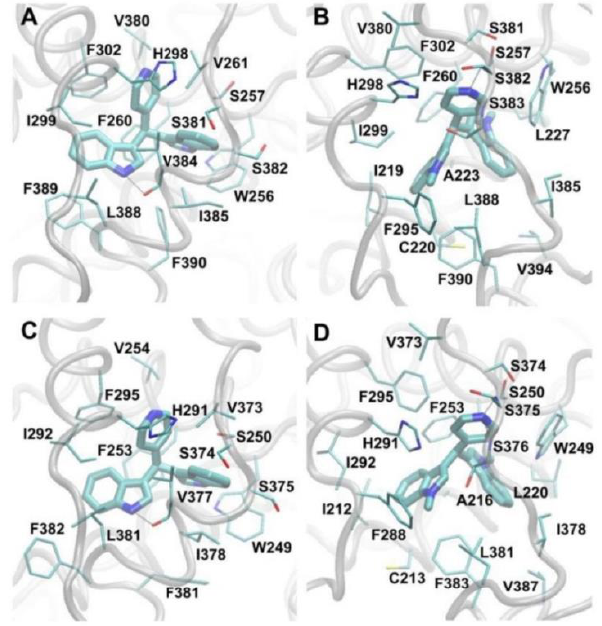
Figure 9. Molecular graphic images of ( A , C ) C-DIM-Pyr4 and ( B , D ) C-1,1-CH3-DIM-Pyr4 in complex with ( A , B ) COUP-TFI and ( C , D ) COUP-TFII. The compounds are shown in licorice representation. Interacting COUP-TFI/2 residues are shown in thin licorice representation, and COUP-TFI/2 backbone atoms are shown in transparent, gray tube representation. Hydrogen bonds are indicated using black, dotted lines.